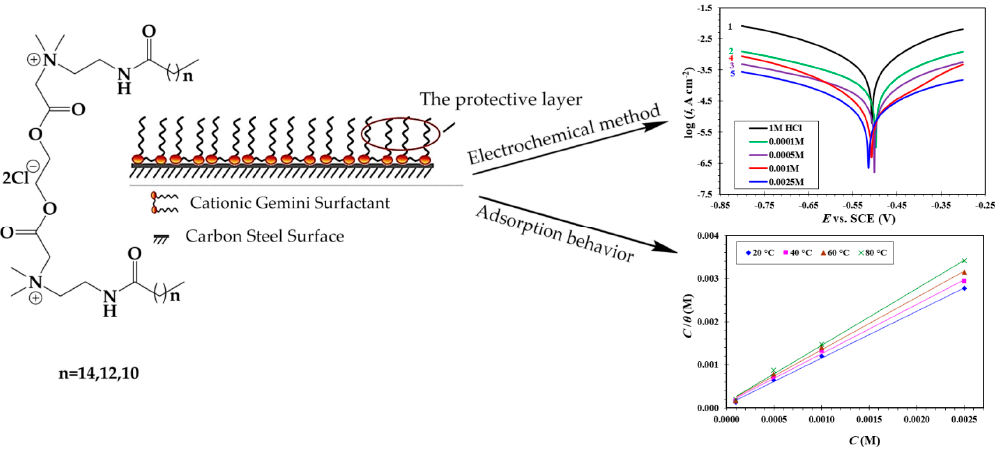
Figure 24. Dependence of the e ffi ciency of the synthesized inhibitors on the chemical structure and surface